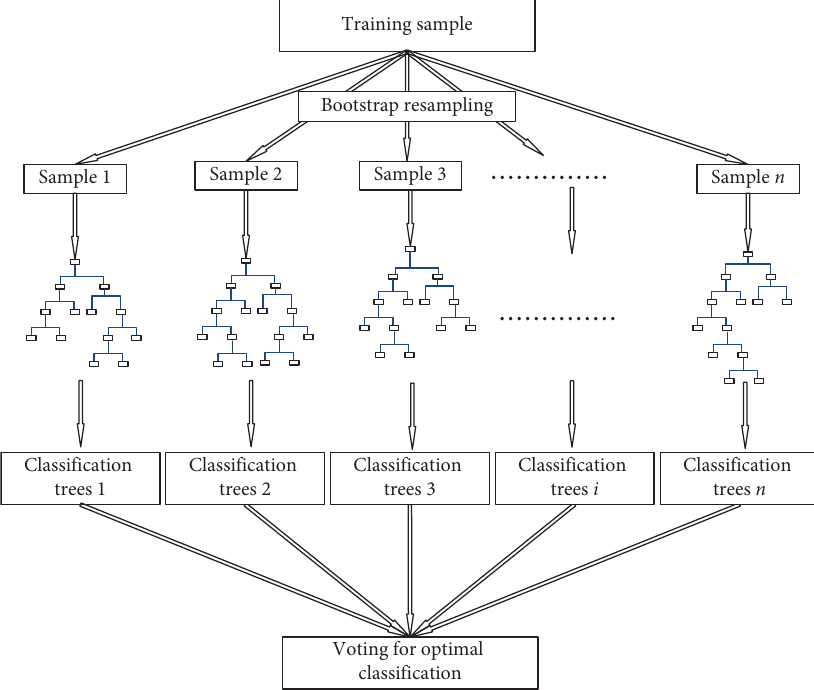
Figure 14: Process chart of Random Forest